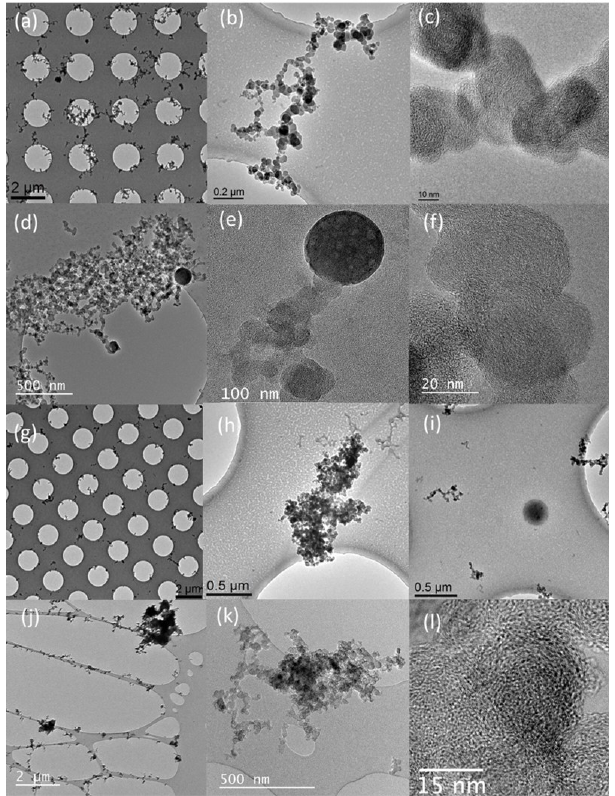
Figure 6. TEM images of samples collected during Artemis urban cold cycle: (a–c) GDI1 vehicle (dilution ratio 40), the sample was collected during the first 120s of the cycle; (d–f) GDI2 vehicle (di- lution ratio 46), the sample was collected during the first 120s of the cycle; (g–i) D1 vehicle (dilution ratio 40), the sample was collected during the first 300s of the cycle and during the Artemis motor- way cycle; (j–l) D3 sampling the first 45s of the motorway cycle (dilution ratio 2), tiny metallic inclusions are observed in panel (l)